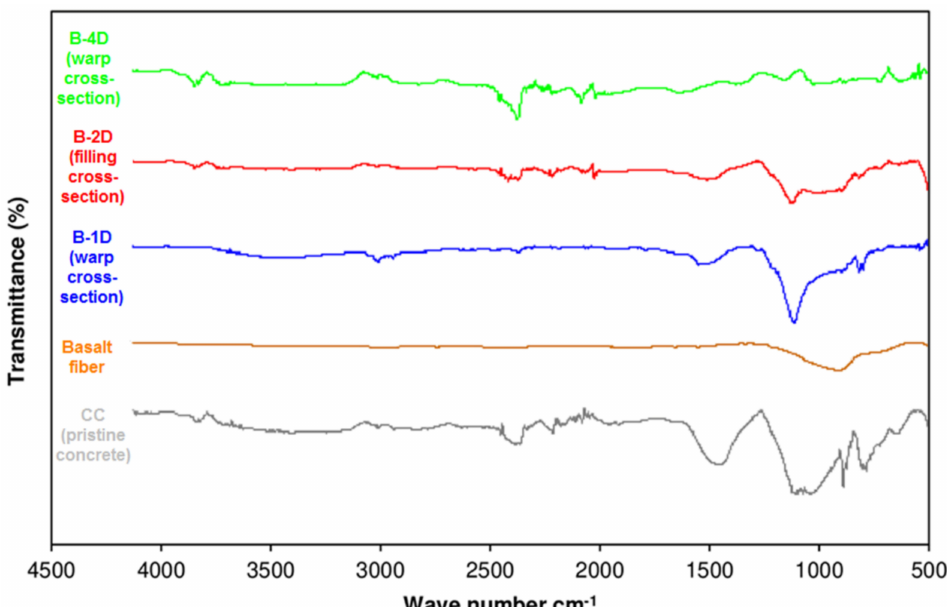
Figure 15. Fourier transform infrared spectra of CC (pristine concrete), basalt fiber, B-1D, B-2D and B-4D concrete composites.